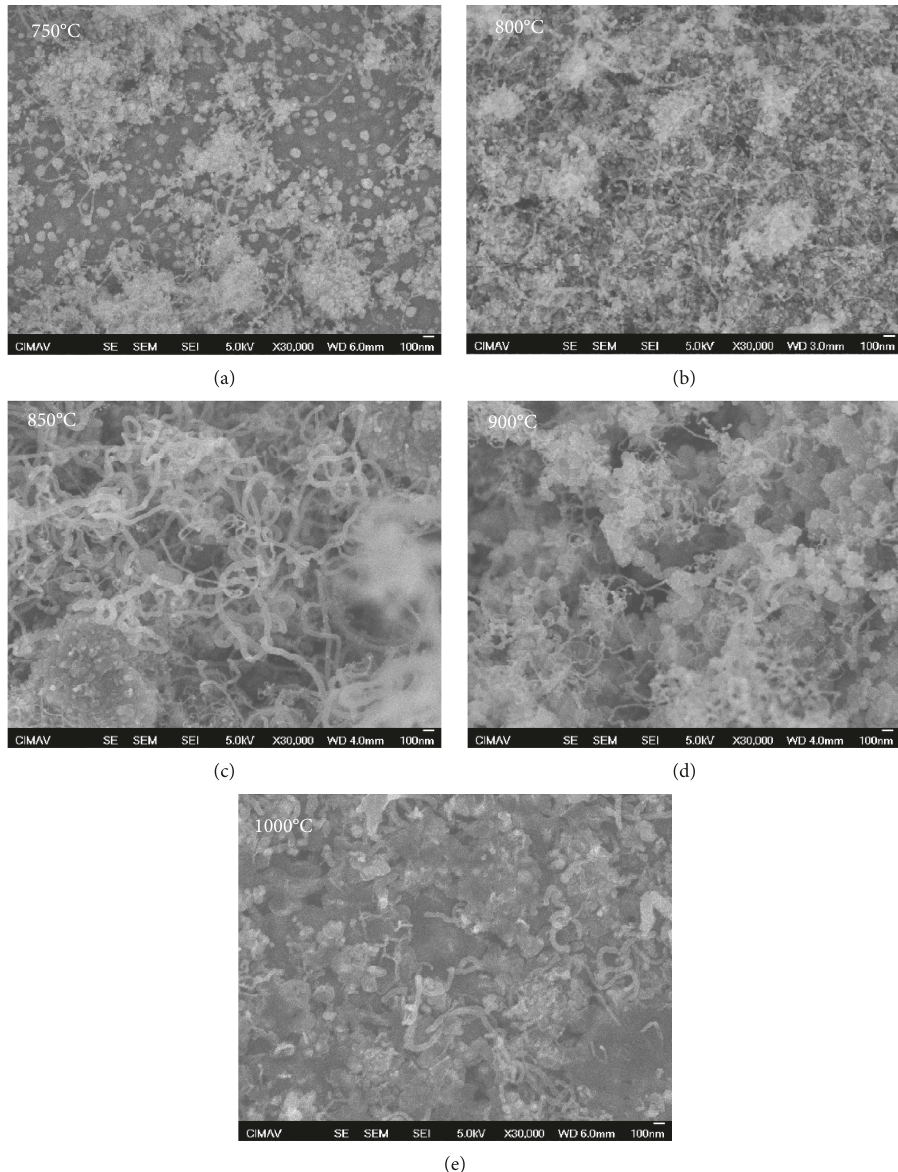
Figure 1: SEM images of CNTs (a) at 750 ° C, (b) at 800 ° C, (c) at 850 ° C, (d) at 900 ° C, and (e) at 1000 °